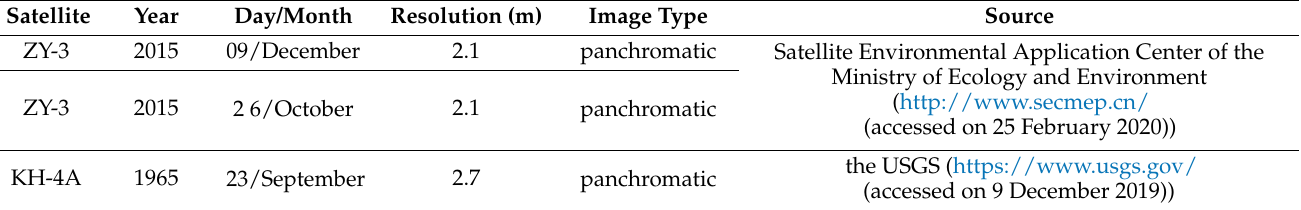
Table 1. ZY-3 satellite and KH-4A satellite specification